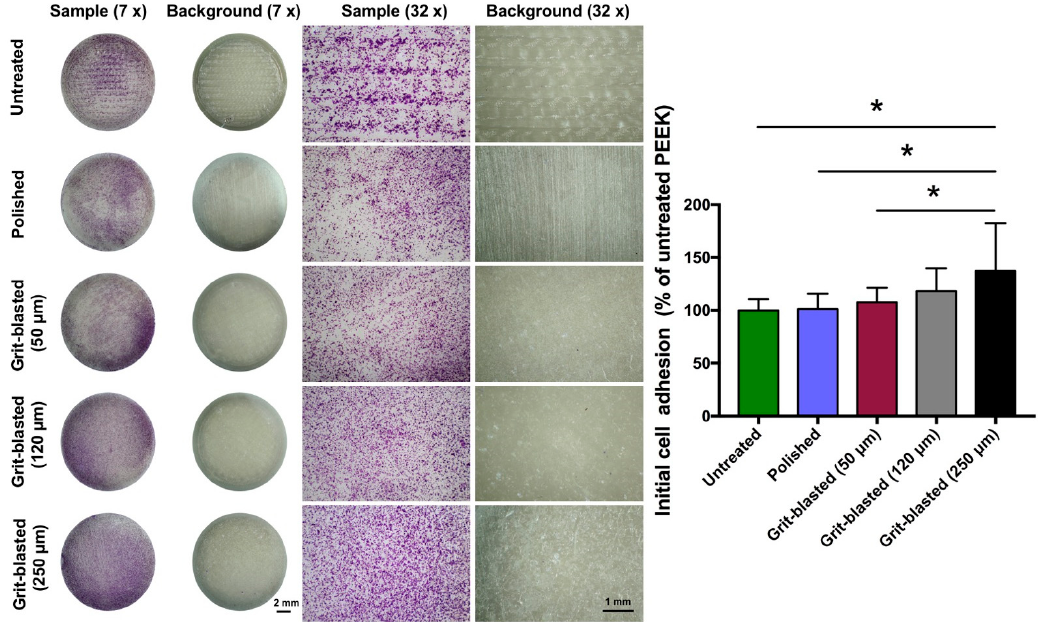
Figure 4. Initial cell adhesion test of the FFF 3D printed PEEK samples in different groups. Representative images of crystal violet-stained osteoblasts on the sample surfaces after 4 h in culture. Left: overview, mag. 7×; right: detail, mag. 32×. The bar chart shows the relative absorbance of the different groups (normalized by the untreated FFF 3D printed PEEK). The data are presented as means ± standard deviations, * p < 0.05.